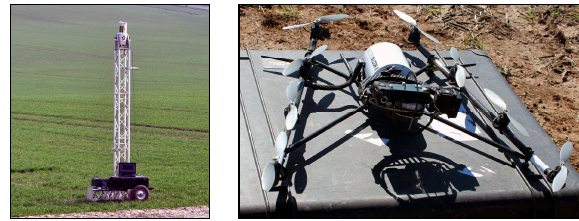
Figure 1. TLS with high tripod and UAV.